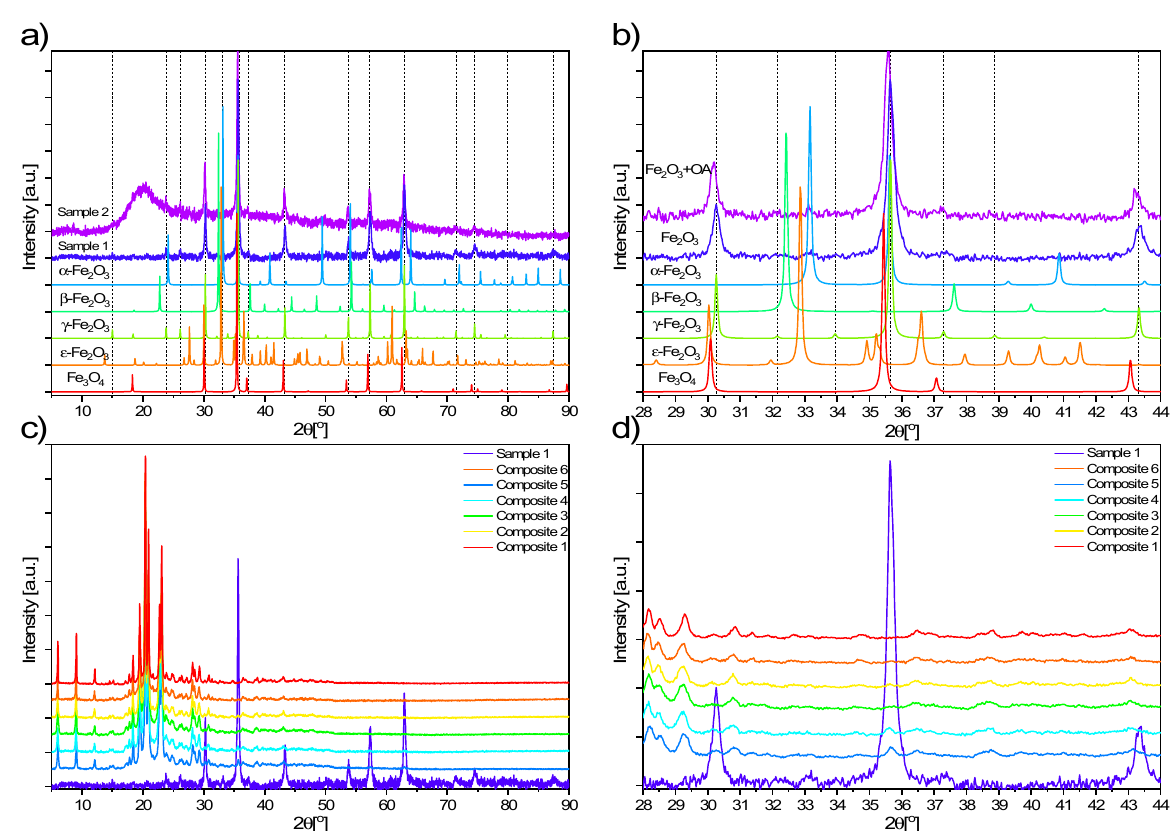
Figure 2. ( a ) XRD patterns of Sample 1 (Fe 2 O 3 ), Sample 2 (Fe 2 O 3 + OA) and reference materials in the ranges 5–90° and ( b ) 28–44°. ( c ) Dashed lines correspond to the positions of diffraction peaks for maghemite. XRD diffractograms of Composites 1–6 and Sample 1 registered in the ranges 5–90° and ( d ) 28–44°.